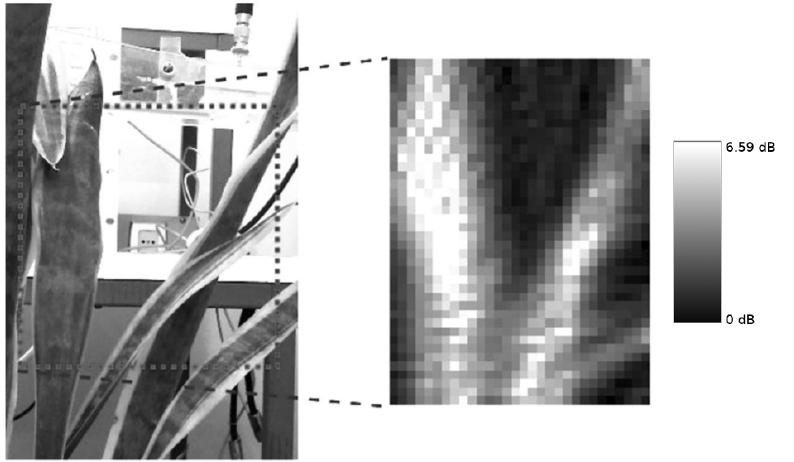
Figure 9. Test results with a cactus-like plant